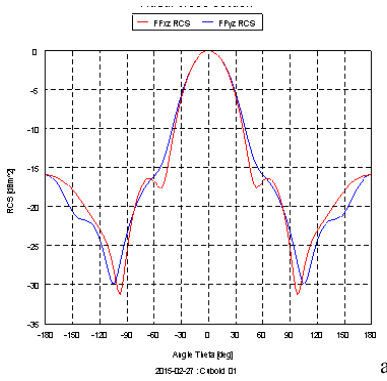
Fig.2. Linear chain of 3 mesoscale dielectric cube: n=1.41, L=H=1λ, spacing = 2.5λ.